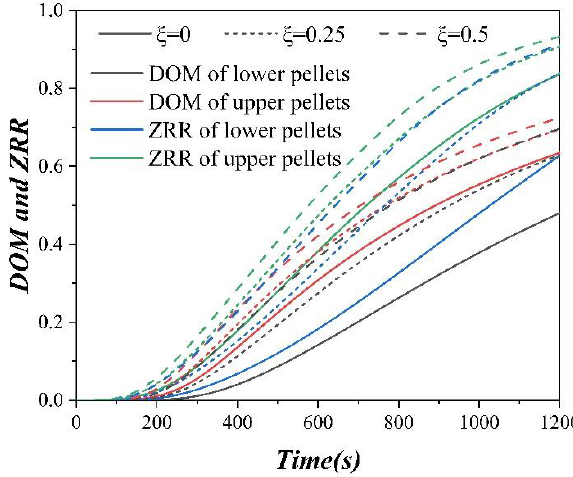
Figure 15. Influence of o ff set ξ on the values of DOM and Figure 15 . Influence of offset 𝜉 on the values of DOM and ZRR.